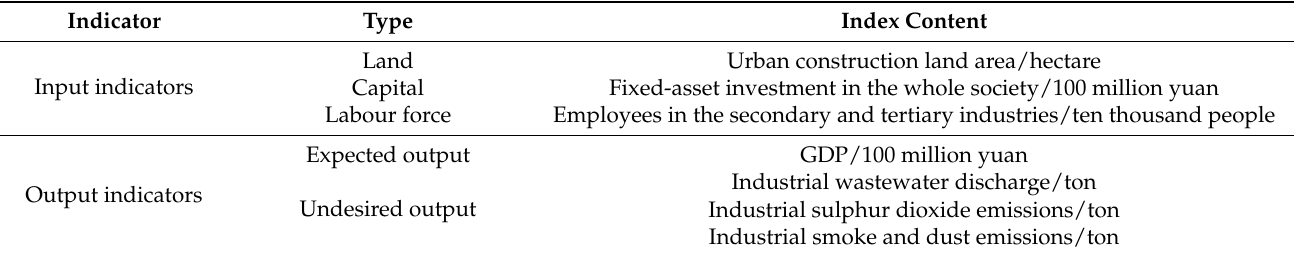
Table 1. Input–output indicator system for urban construction land-utilisation